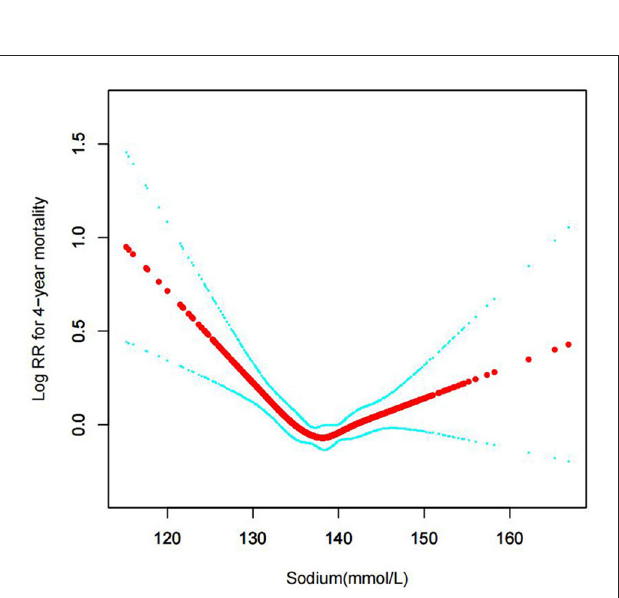
FIGURE8 Association between serum sodium levels and 90-day all-cause mortality (After adjustment for other covariates). A generalized additive model (GAM) revealed a threshold, non-linear relationship between serum sodium levels and 90-day all-cause death. U-shaped relationships were observed after adjustment for other covariates by spline smoothing plot. The smooth curve fit between variables is shown by a solid rad line. The 95% confidence interval from the fit is represented by imaginary blue lines.